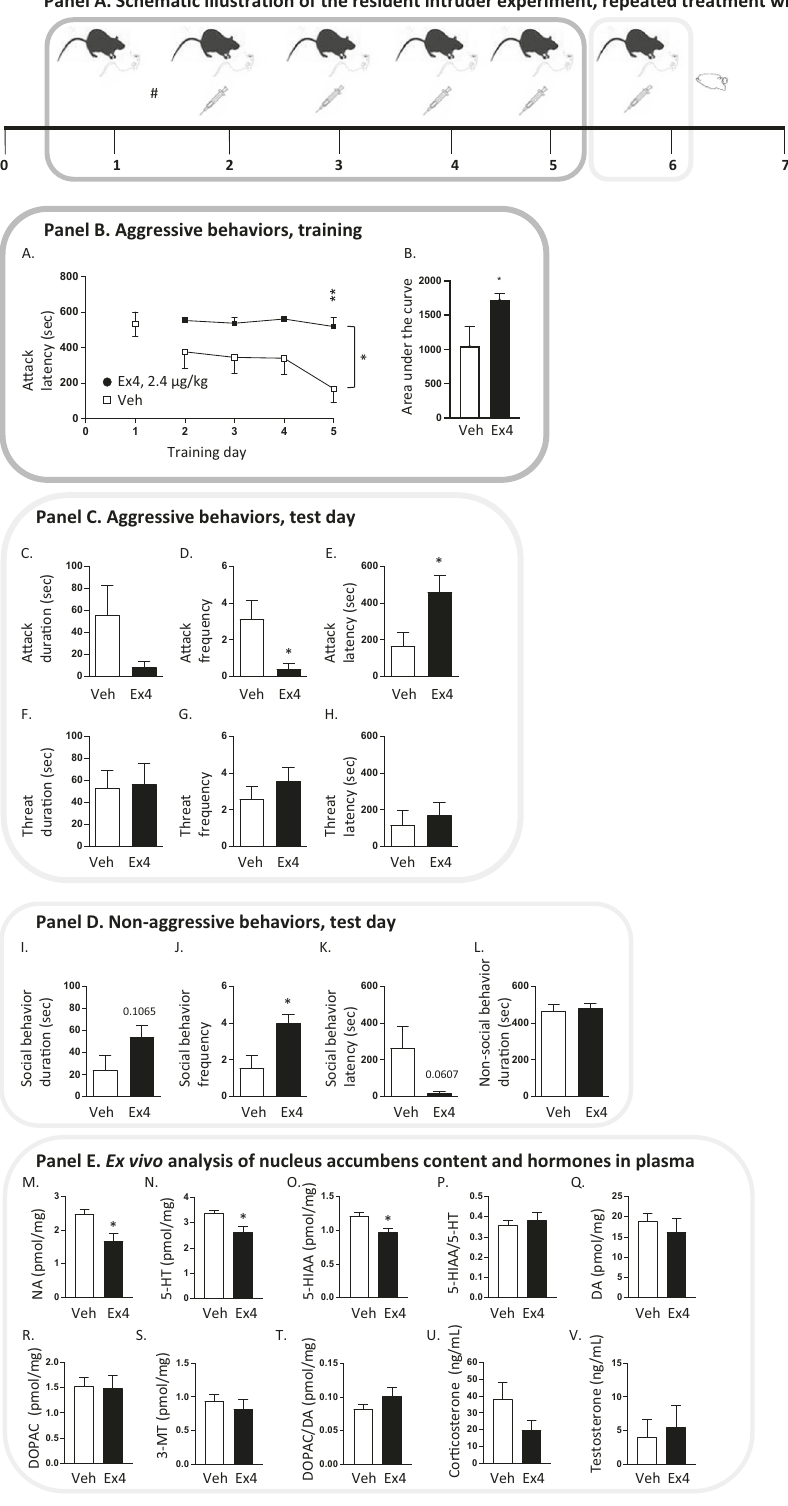
Statistical analysis of the human genetic study . A linear mixed effect model in the MIXED procedure of SAS 9.3 (SAS Institute, Inc, Cary, NC, USA), was used. The analysis includes scores from all genotyped individual. This model adjusts for (i) the dependent nature of twin observations and (ii) dependence of individuals from the same family. Two separate variance – covariance matrices was modeled (monozygotic and dizygotic Translational Psychiatry (2022)